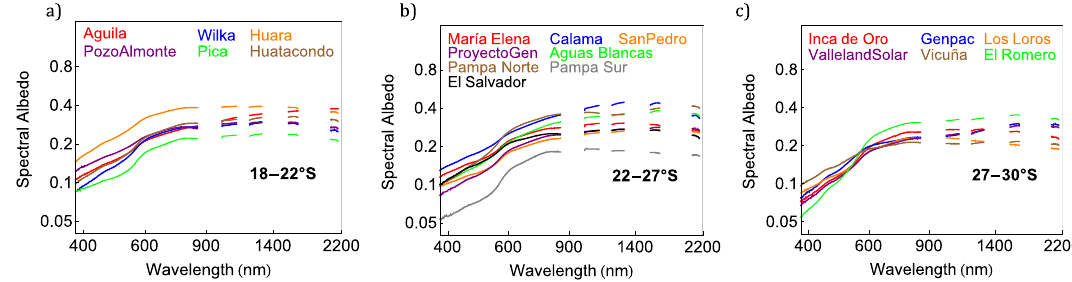
Figure 2. Ground-based measurements of the spectral albedo carried out at 20 sites in the Atacama Desert. Spectra are truncated around water vapor absorption bands. Sites were clustered according to the latitude: ( a ) from latitude 18° S to latitude 22° S, ( b ) from latitude 22° S to latitude 27° S, and ( c ) from latitude 27° S to latitude 30° S. Plots were generated by using Python’s Matplotlib Library 44